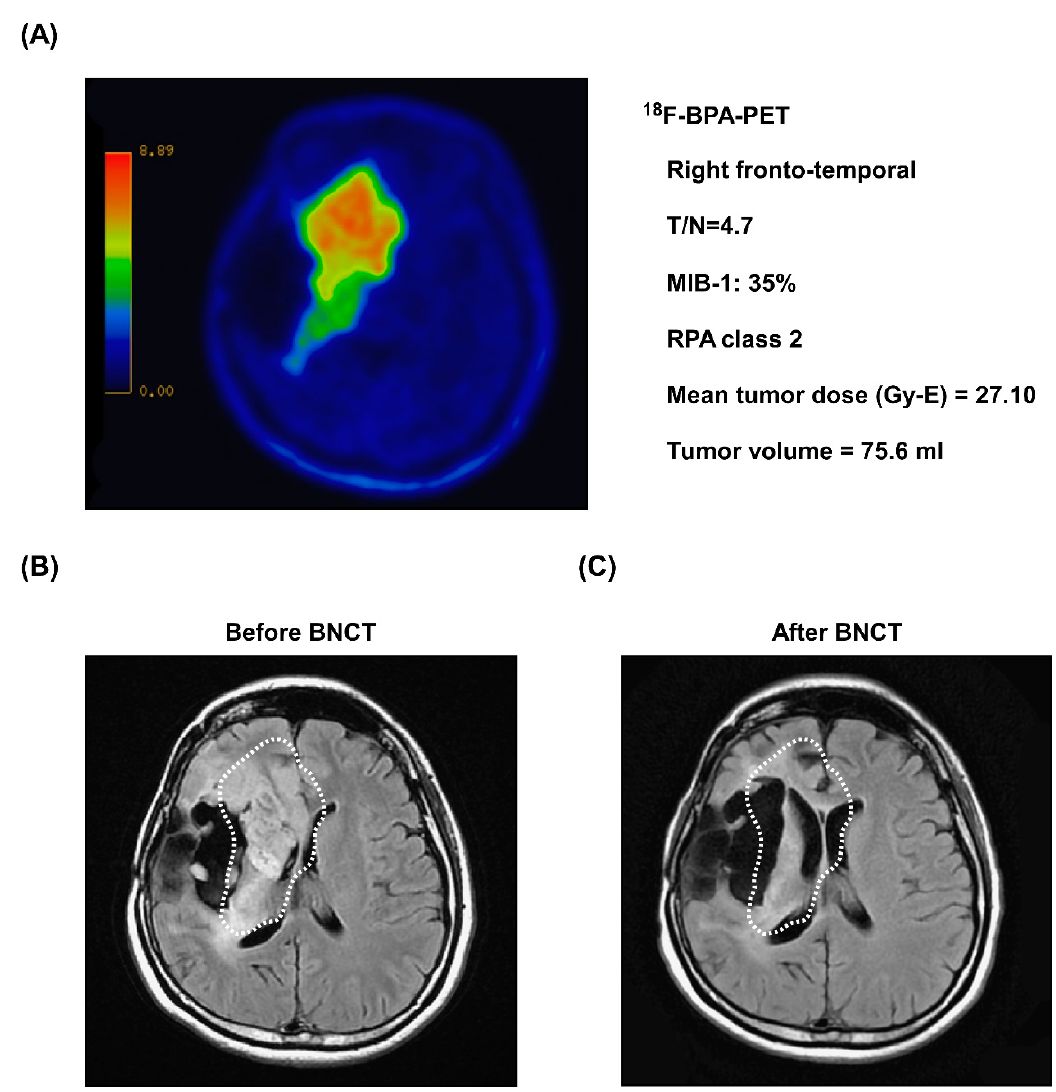
Figure 5. Representative images of tumor shrinkage after BNCT treatment. ( A ) Before BNCT treatment, 18 F-BPA-PET revealed the location of strong tumor activity in the right fronto-temporal lobe. ( B ) MRI imaging of the patient before BNCT treatment. An anaplastic astrocytoma was observed in the right temporal lobe (white dashed circles). ( C ) Three months after BNCT treatment, a follow-up MRI image of the patient showed a significant reduction in tumor volume (white dashed circles).